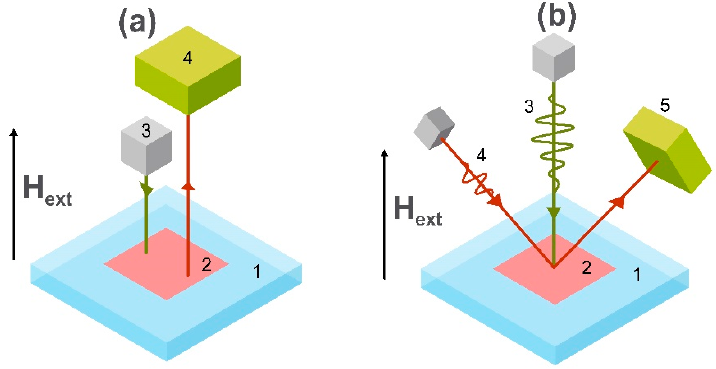
Figure 10. Schematic images of two geometries of the sensing elements of magnetometers based on the excitation of nitrogen-vacancy centers in diamond where H ext is the applied external magnetic field. Panel ( a ) shows the schematic geometry of the continuous illumination protocol where the numbers refer to diamond (1), the nitrogen-vacancy centers in diamond (2), light emitter (3), and the system for detection of the luminescence light (4). Panel ( b ) represents the schematic image of pulsed illumination and resonance relaxometry protocols, where the numbers refer to diamond (1), the nitrogen-vacancy centers in diamond (2), pump beam (3), probe beam (4), and detecting system (5).